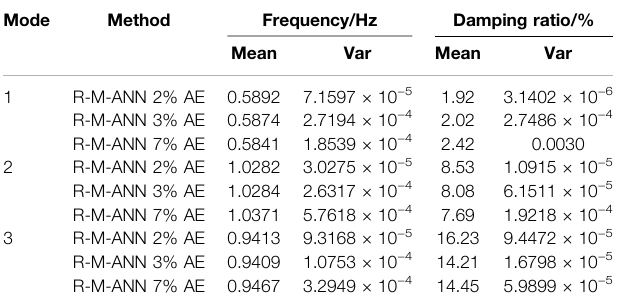
TABLE 2 | Identi fi cation results for the R-M-ANN model with different ambient excitations (AEs) for the four-generator two-area system.